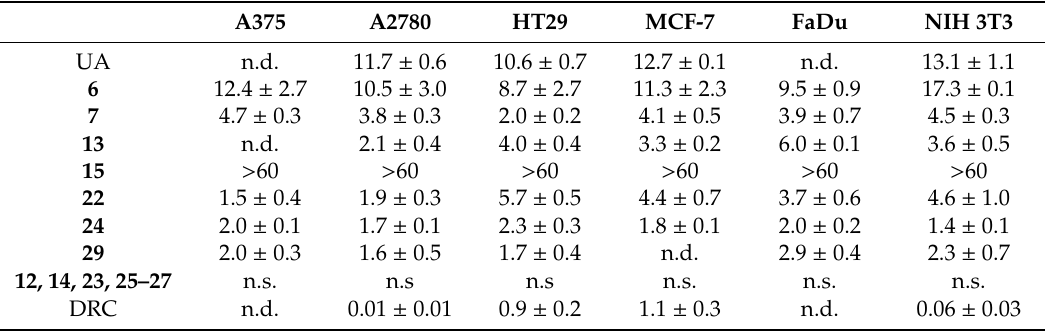
Table 1. Cytotoxicity of UA-DOTA conjugates ( 12 – 15 , 22 – 27 , 29 ), DOTA precursors ( 6 , 7 ), ursolic acid (UA), and doxorubicin hydrochloride (DRC): EC 50 values from SRB assays after 72 h of treatment are given in µ M (n.d. not detected; n.s. not soluble); the values are averaged from three independent experiments each performed in triplicate; confidence interval CI = 95%.